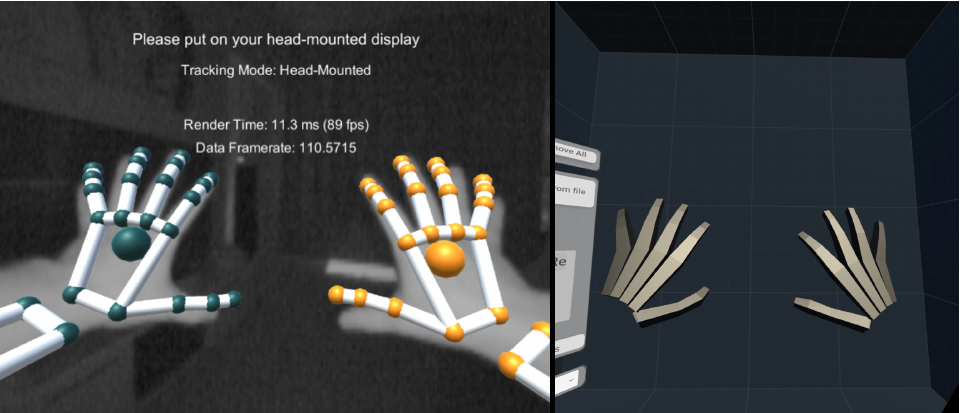
Figure 1. The left image shows a still from Leap Motion Controller’s infrared camera overlaid with the interpreted hand model. The image on the right shows how the hands appear in